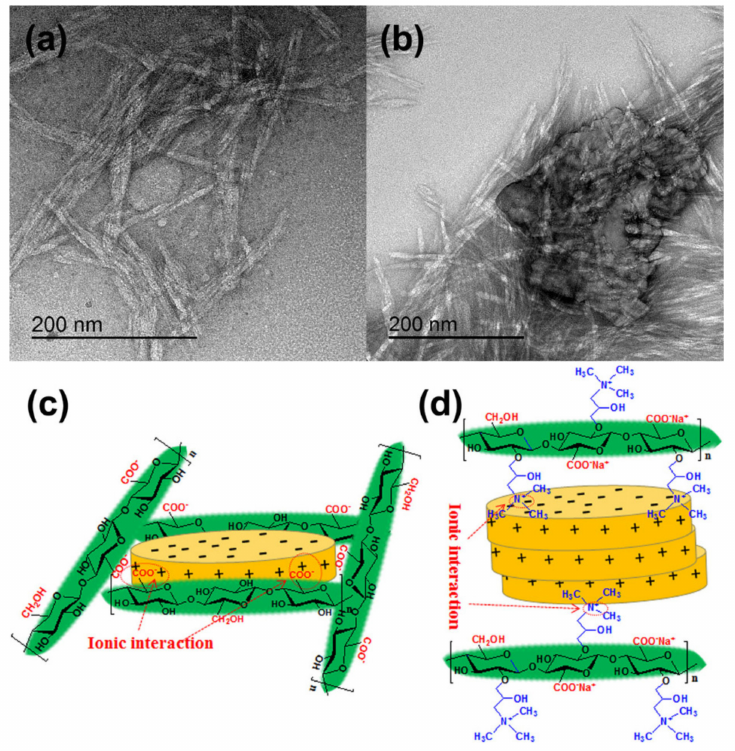
American Chemical Society,